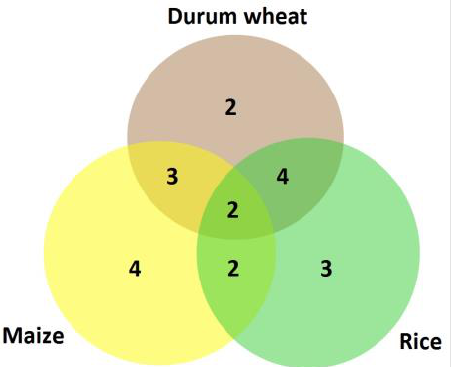
Figure 6. Venn diagram of similar expression response patterns during S1 and S2 stress stages for dehydration stress memory genes (a total of 11 genes) from durum wheat ( Triticum turgidum L. ssp. durum (Desf.)) and orthologs from maize ( Zea mays ) and rice ( Oryza sataiva ).